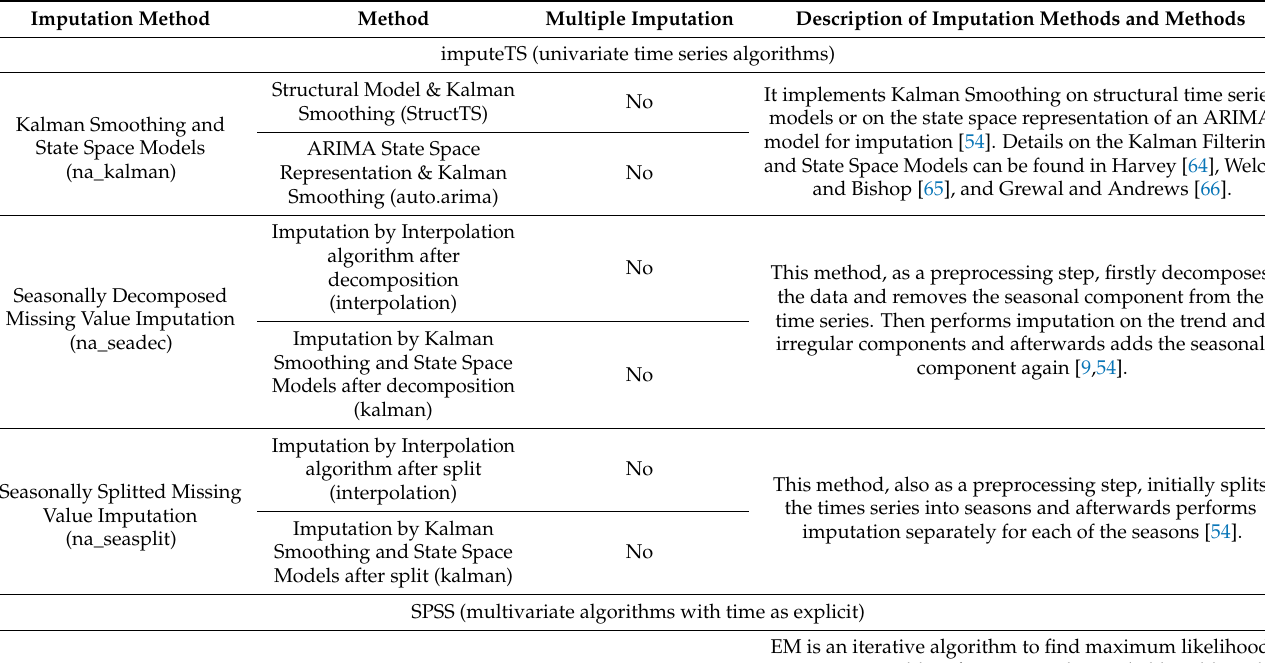
Table 1. Classifications of the algorithms and brief descriptions of the methods used in this